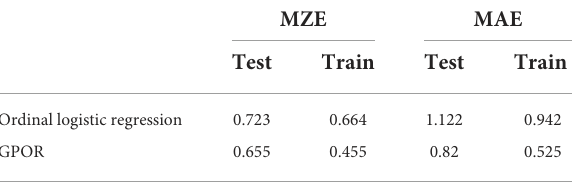
TABLE 1 Cross-validation results. MZE MAE Test Train Test